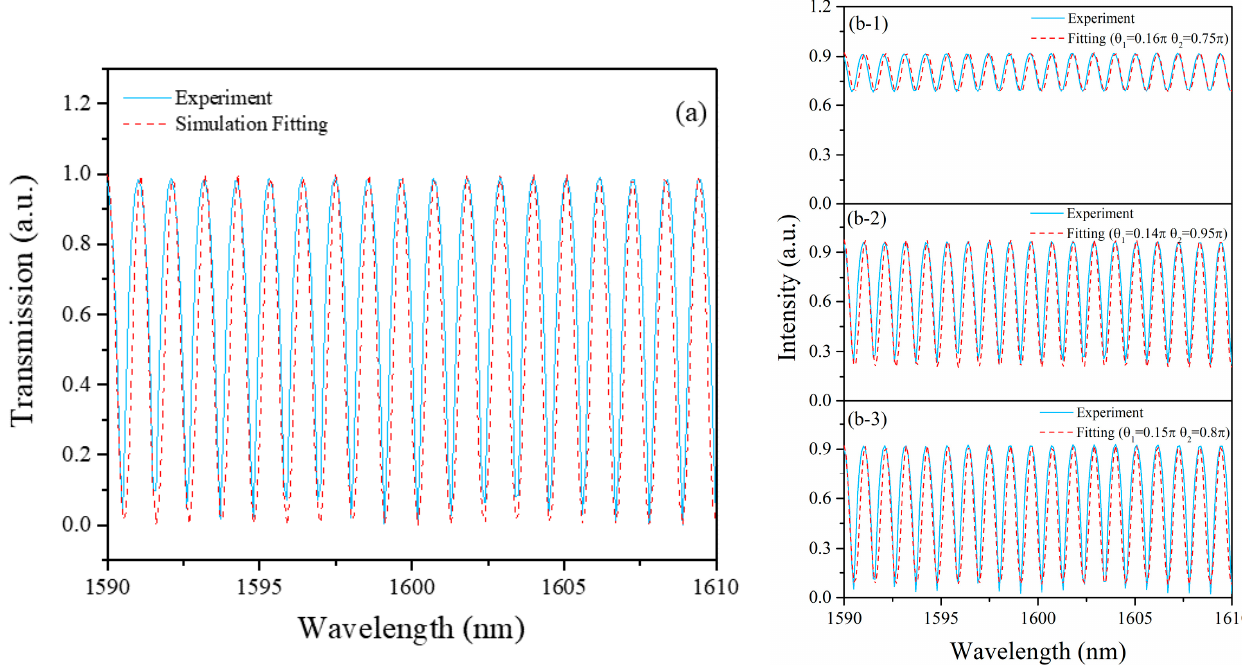
Figure 2. ( a ) Transmission spectrum of fiber-based Lyot filter in L-band (solid, experimental result; dashed, simulated result). ( b-1 – b-3 ) Transmission spectrum with different angles of θ 1 and θ 2 (solid, experimental result; dashed, simulated result).